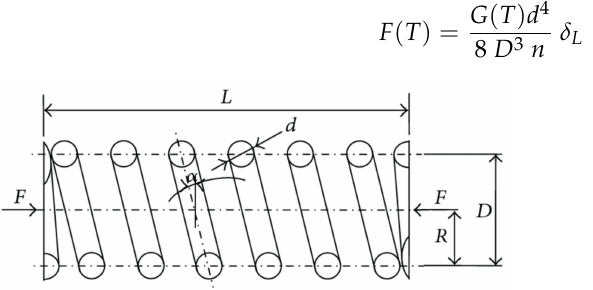
Figure 7. Spring geometrical parameters.